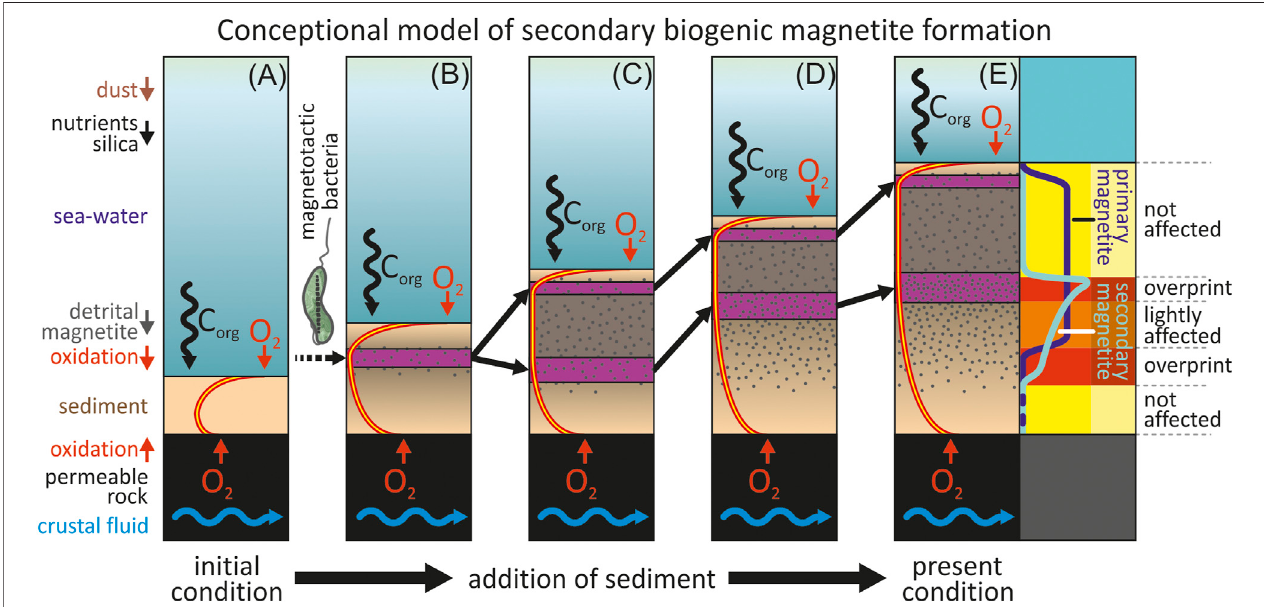
FIGURE9| Conceptualmodelofsecondarybiogenicmagnetiteformationininverselyoxygenatedsediments. (A) Thethinsedimentlayeronyoungcrustisstillfully oxic and no magnetotactic bacteria exist. (B) Magnetotactic bacteria start to populate the increasingly oxygen-starved layer in the sediment subsurface and start magnetitebiomineralization. (C) Increasingoxygenconsumptionbyorganicmatterburialandenlargingdiffusionlengthsleadstotheformationofasuboxiczonesplitting the population of microaerophilic magnetotactic bacteria into an upper and a lower community. (D) Secondary biogenic magnetite is formed along the lower oxic/ suboxic redox boundary that slowly propagates upwards through the sediment column. (E) Stagnation of the upward movement of the lower oxic/suboxic redox boundary leads to an increasingly arrested lower zone of biogenic magnetite biomineralization. At right: Magnetic overprinting (red and orange areas) occurs where the concentration and natural remanence ofthe secondary biogenicmagnetite (turquoise curve) exceeds theconcentration ofprimary biogenicplus detrital magnetite (dark blue curve).